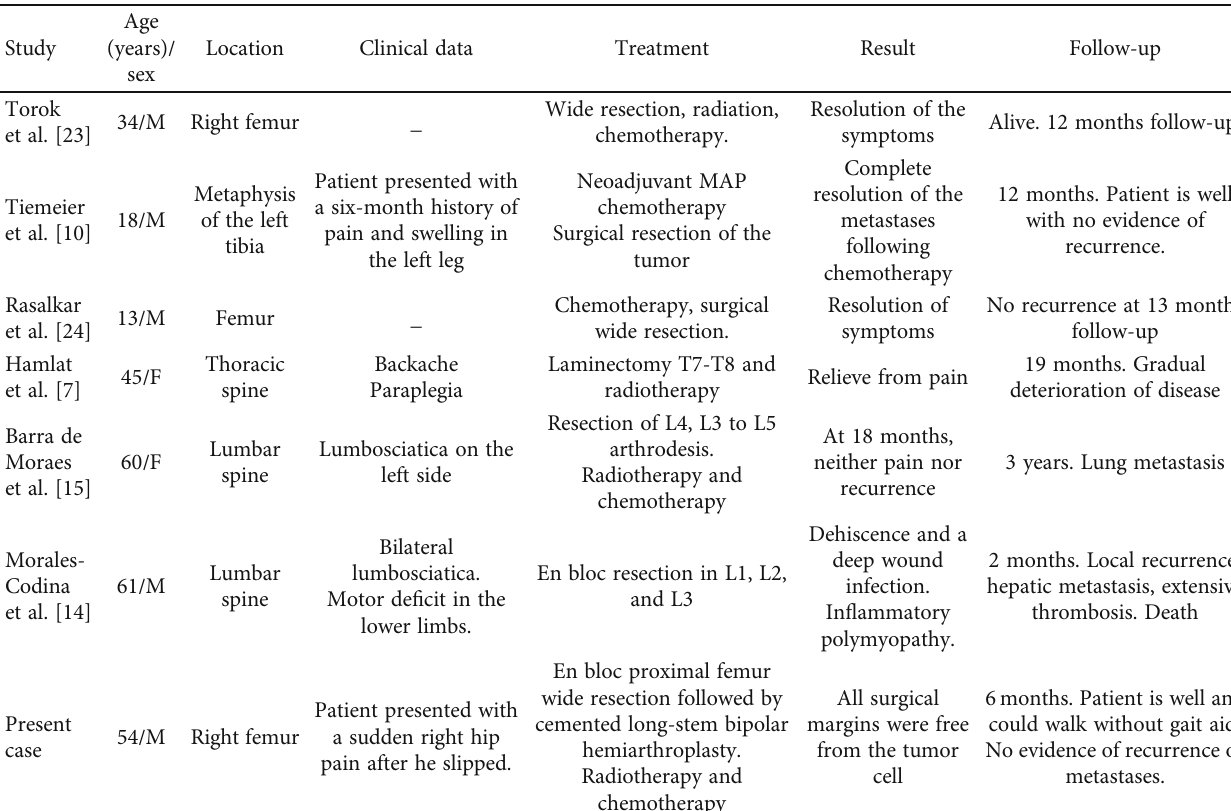
Table 1: Clinical, demographic features, type of treatments, results and outcomes of the present case, and reported cases of pleomorphic liposarcoma in the